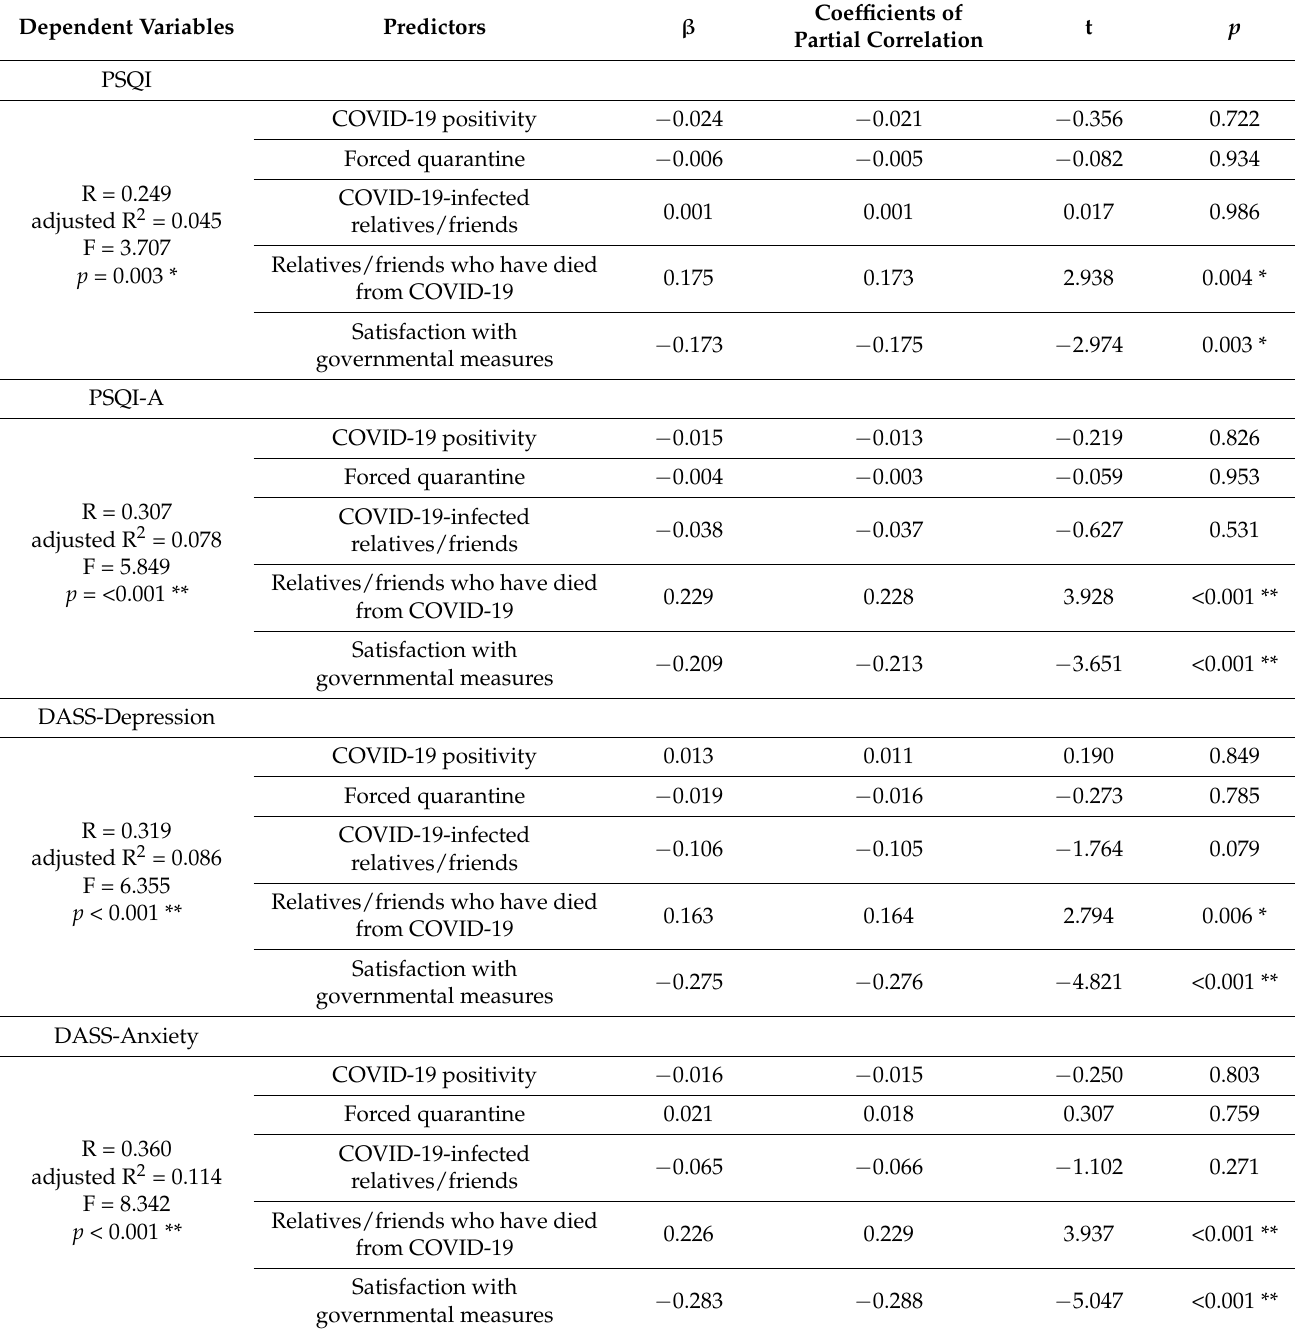
Table 4. Results of multiple regressions ( p ≤ 0.05), considering sleep and psychological symptoms during the current period (PSQI, PSQI-A, DASS-Depression, DASS-Anxiety, DASS-Stress scores on T1) as criterion variables and COVID-19-related personal experiences (COVID-19 positivity, forced quarantine, COVID-19-infected relatives/friends, relatives/friends who have died from COVID-19, agreement on government measures) as